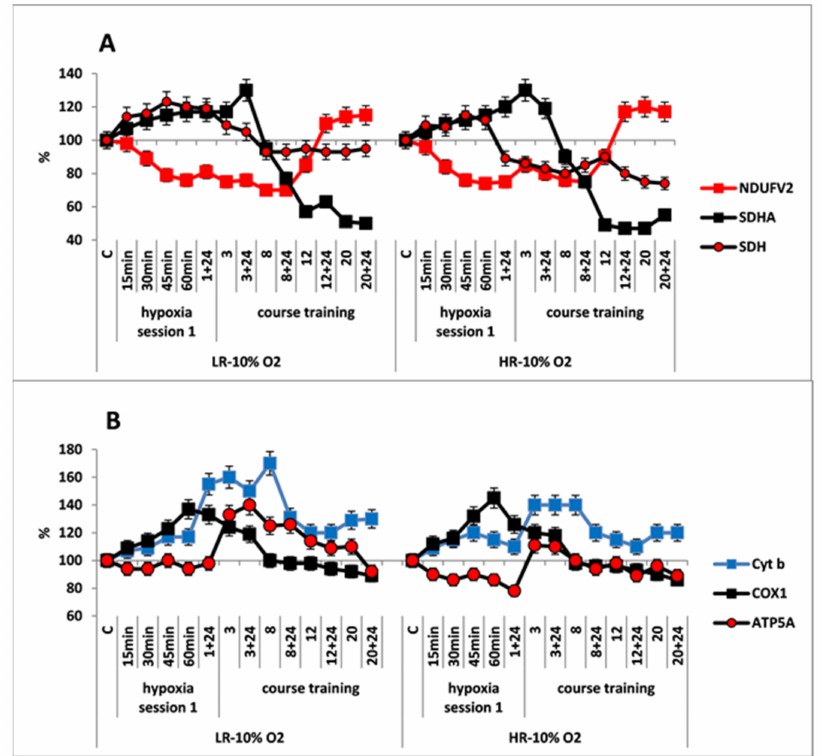
Figure 4. Effect of long-term hypobaric hypoxia (HBH, 10% O 2 ; 20 daily one-hour sessions) on the dynamics of the content of mitochondrial enzymes in rats with low-resistance (LR) and high- resistance (HR) to hypoxia. ( A ) NDUFV2 (MC I), SDHA (MC II) catalytic subunits (% of control) and SDH activity. ( B ) Cyt b (MC III), COX1 (MC IV) and ATP5A (MC V) catalytic subunits (% of control). For other designations, see legends to Figure